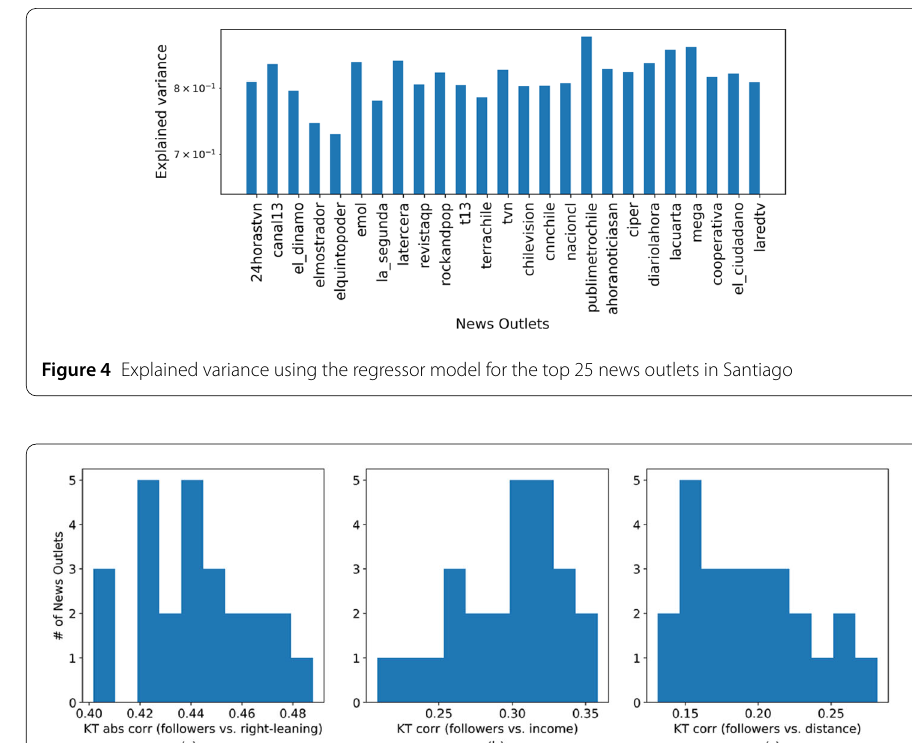
but using data related only to the selected outlet. The results, shown in Fig. 4, confirm that with the selected features, the regressors are able to approximate the distribution of followers ( M = 0.82, SD =